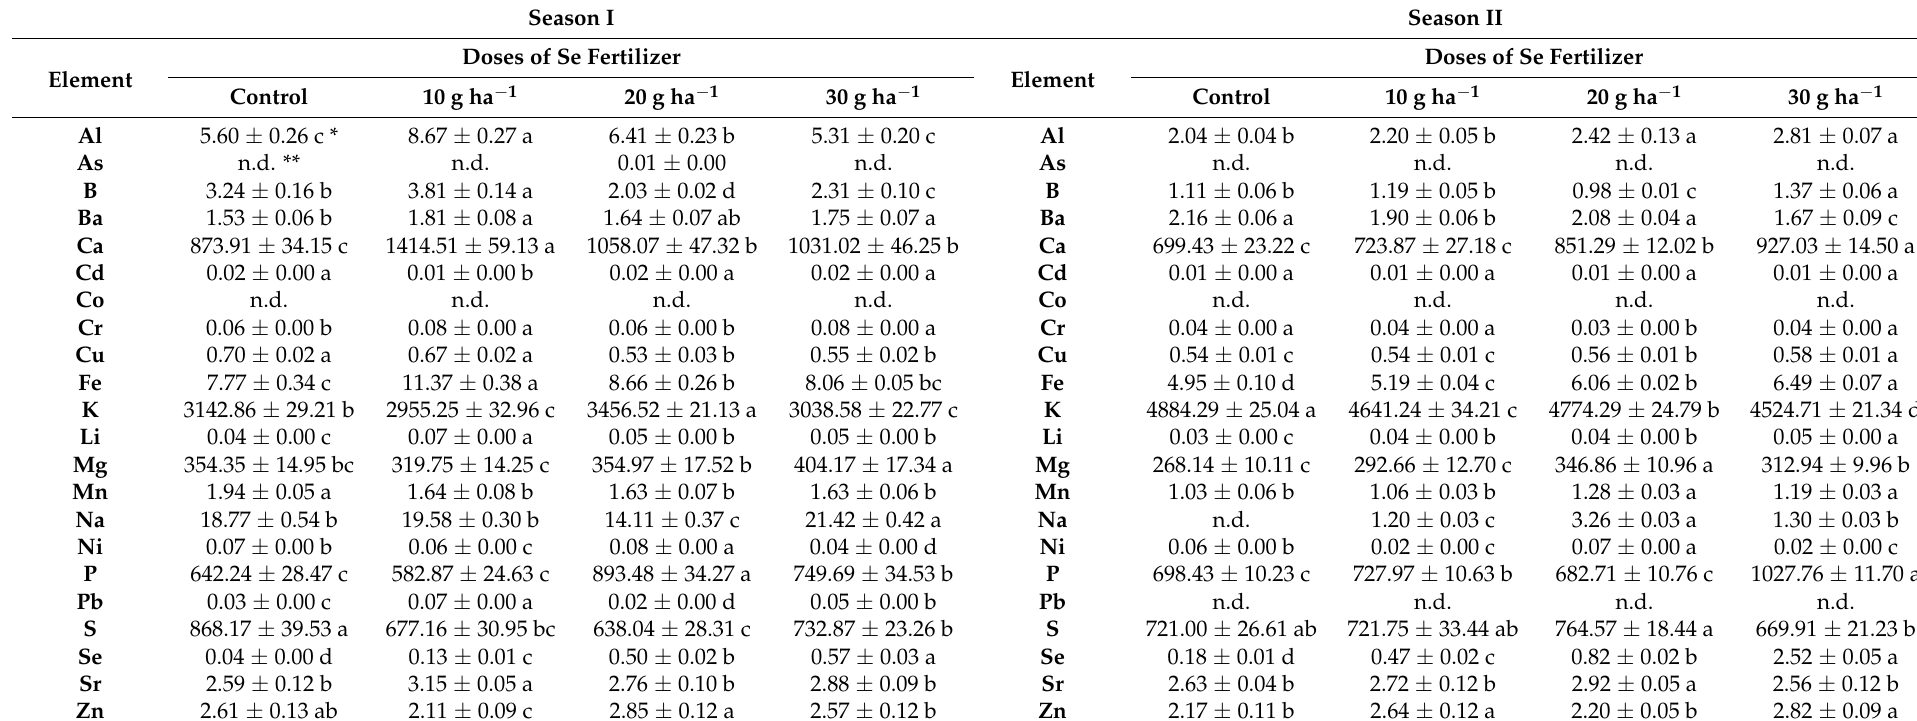
Table 2. The contents ( µ g g − 1 of fresh weight ± SD) of biogenic elements observed in the leaves of A. odorum for both